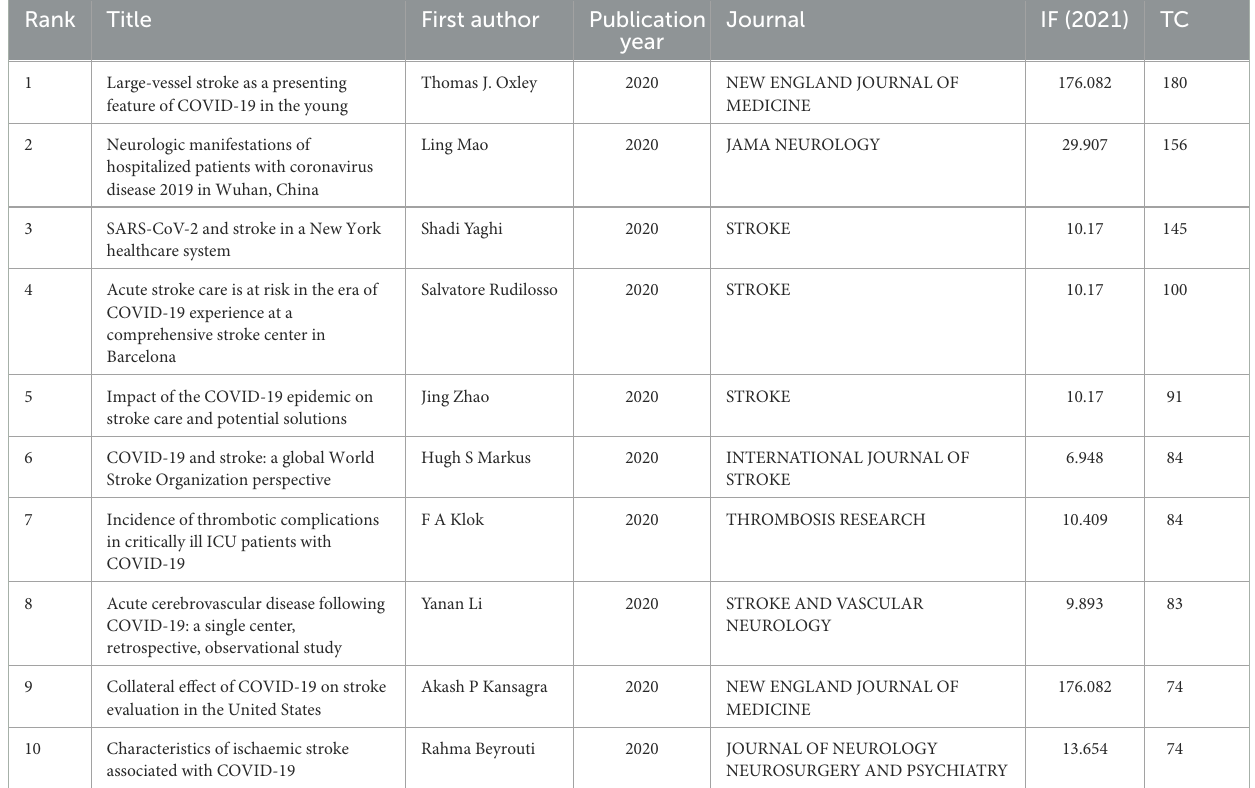
TABLE 7 Top 10 most-cited references in COVID-19 and stroke-related studies ranked by total citations.